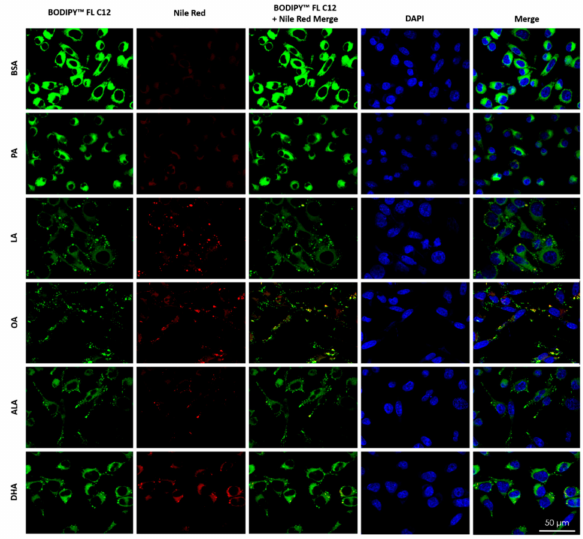
Figure 8. Uptake of BODIPY TM FL C12 and its incorporation into neutral lipids and LDs in BV2 cells. BV2 cells were grown on glass coverslips and treated with 200 µ M FFA or BSA control in serum-free media for 6 h. At the end of treatment, cells were incubated with BODIPY TM FL C12 (green) for fatty acid uptake, stained with Nile Red (red) for neutral lipids, and stained with DAPI (blue) for nuclei, washed, mounted, and visualized under confocal